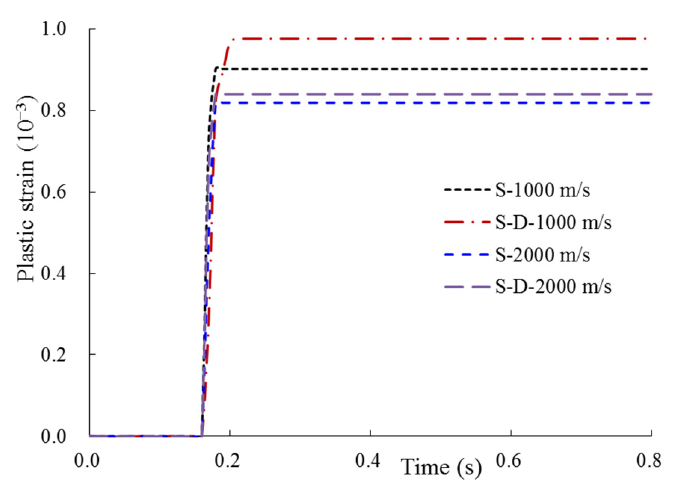
Figure 20. Max plastic strain time-histories of concrete.